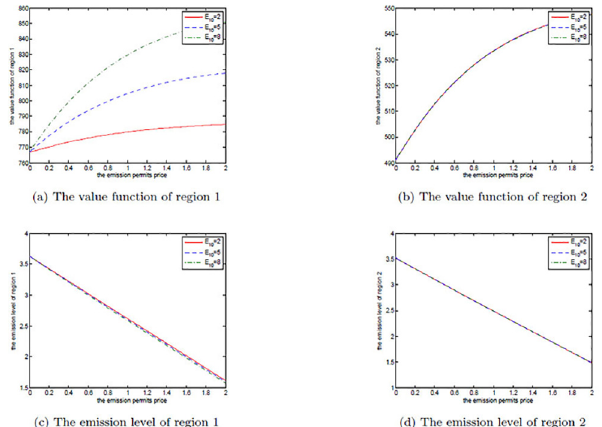
Fig 14. The effects of E 10 on the noncooperative